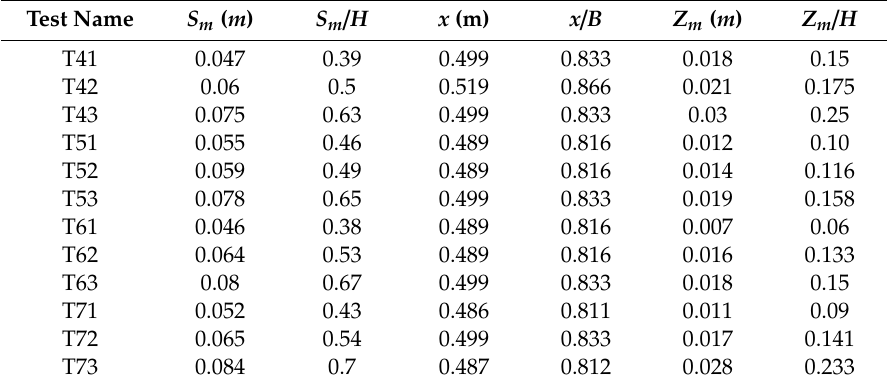
Table 3. Characteristics of maximum scour depth at di ff erent